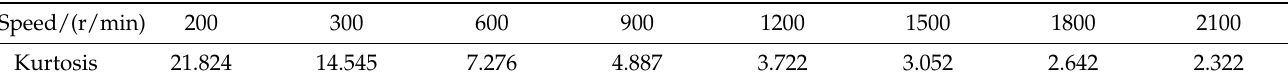
Table 1. Bearing simulation signal cliff at different